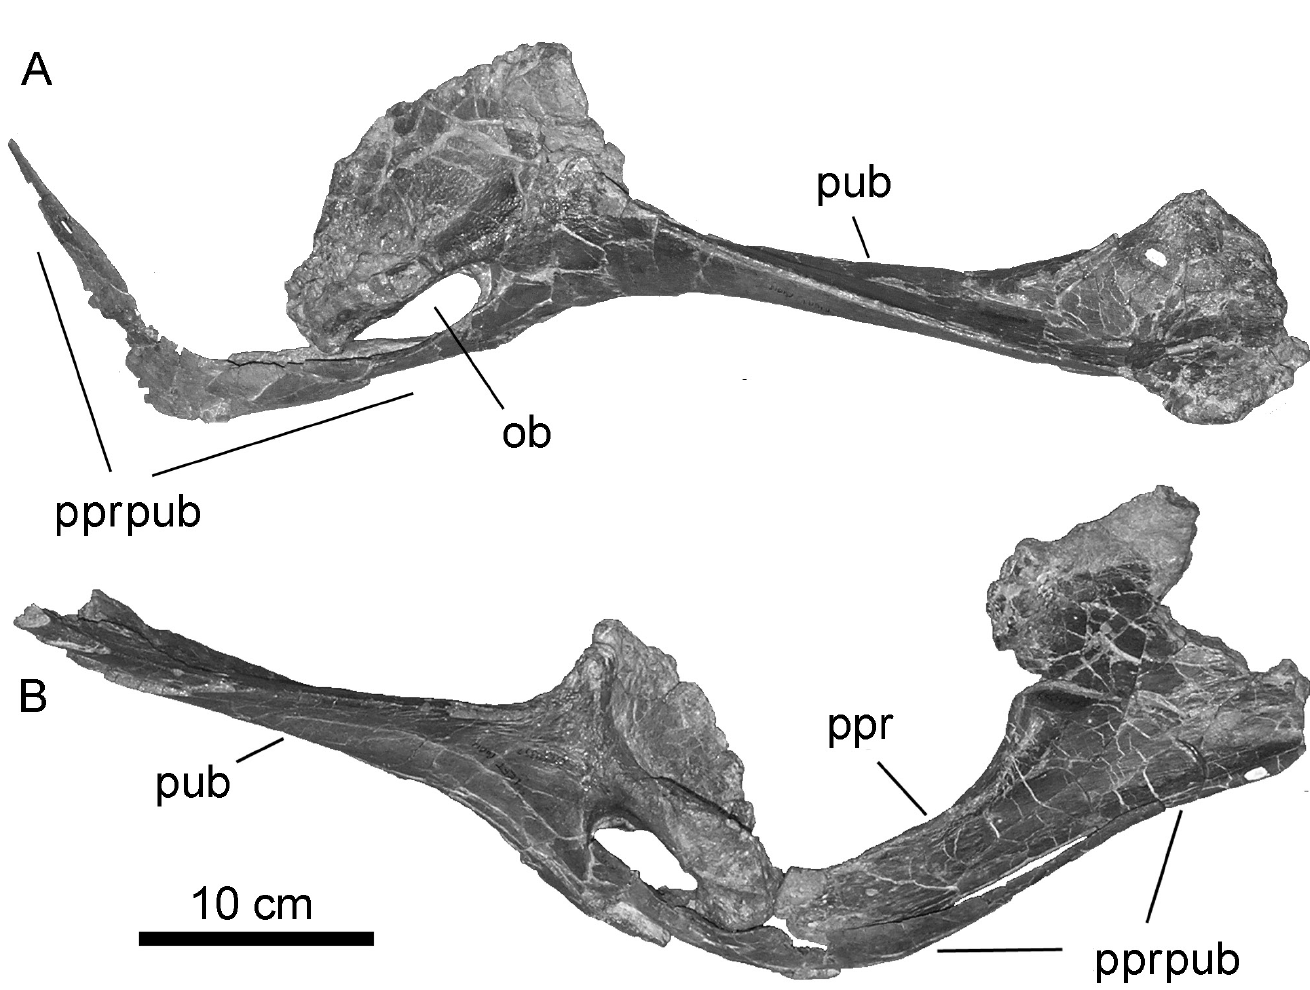
Figure 20. A, right pubis, lateral view; B, left pubis and ischium in articulation, lateral view. Vagaceratops irvinensis , CMN 41357. Tarsus: The right calcaneum remains articulated